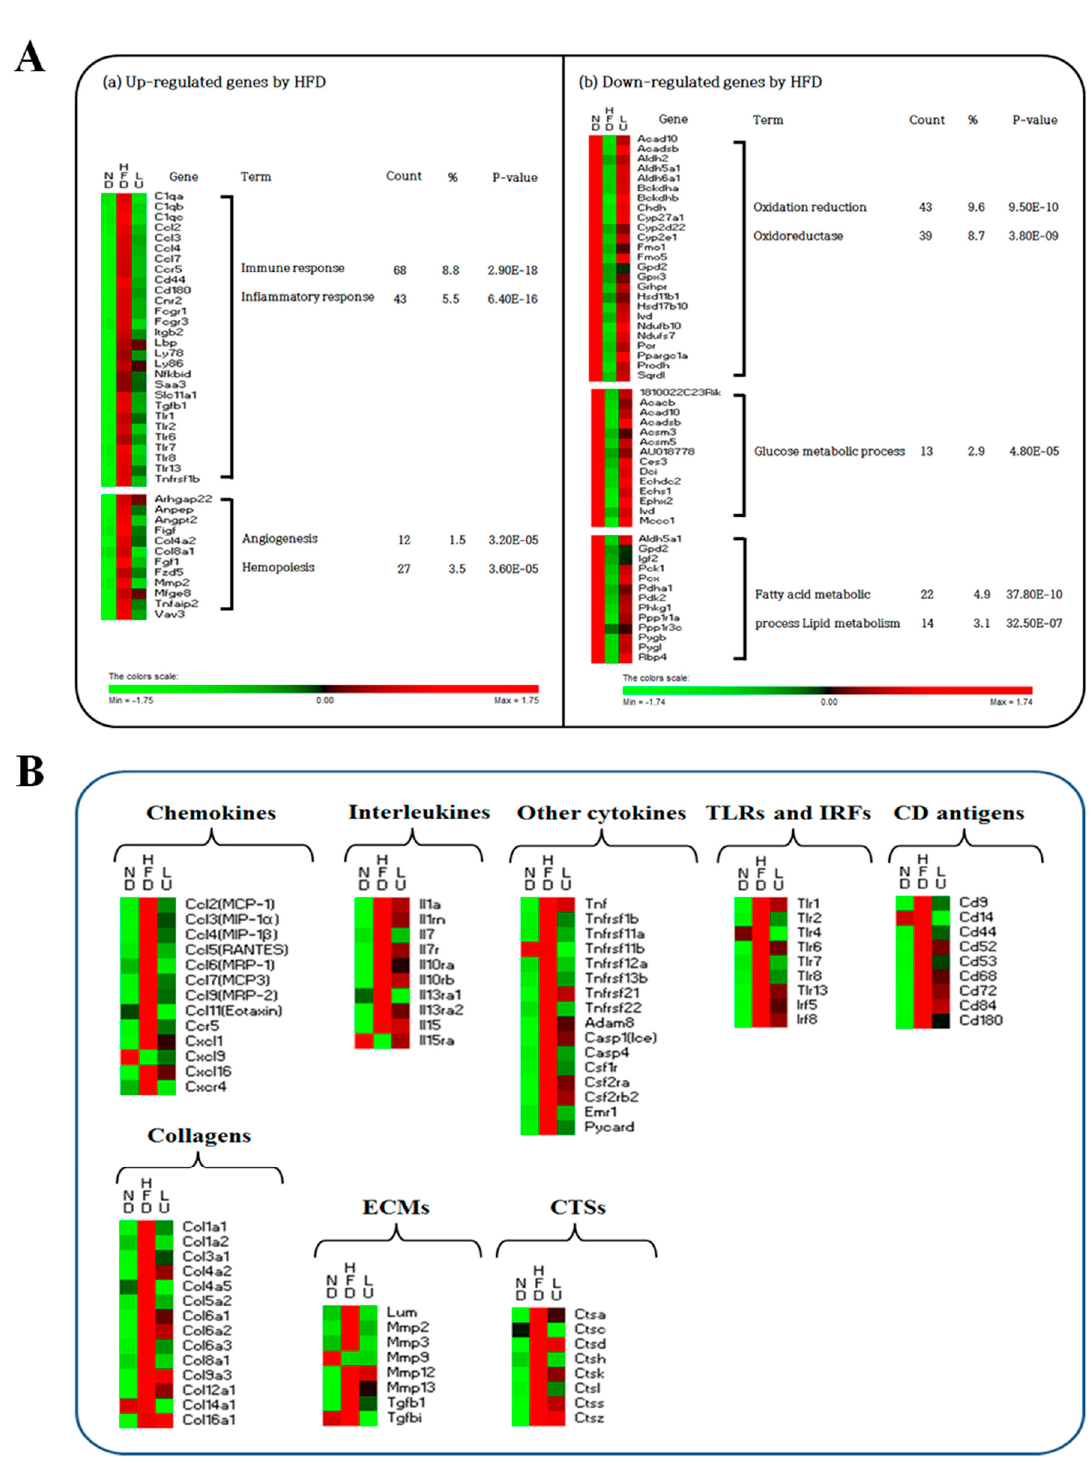
Figure 4. Gene transcription patterns related to inflammation in white adipose tissue. Symbols in red were up-regulated while those in green were down-regulated. ( A ) Functional gene ontology terms enriched among up- or down-regulated genes by the HFD using DAVID (enrichment score >2). ( B ) The heatmap of genes involved in chemokines, interleukins, cytokines, TLRs, IRFs, CD antigens, collagens, ECMs, and CTSs.